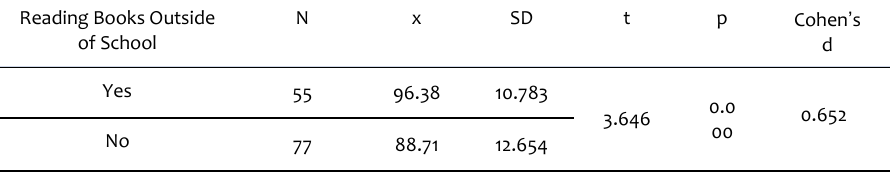
Table 5. Students' reading motivation scores in relation to reading books outside of school Reading Books Outside of